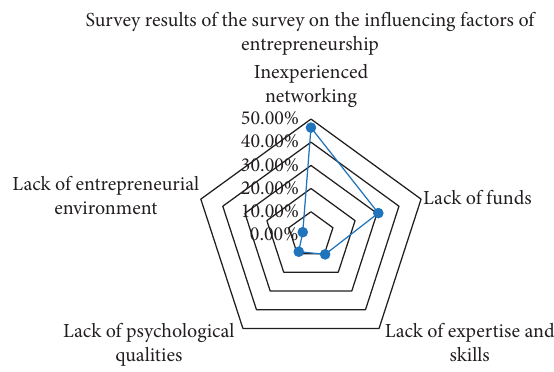
Figure 10: QS results of infuencing factors of